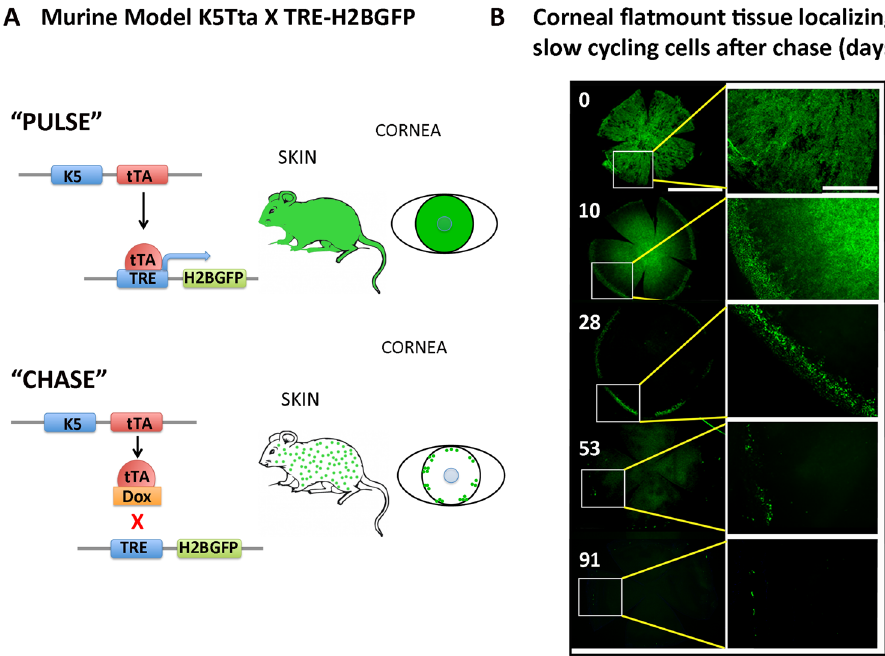
Figure 1. Murine K5Tta × TRE-H2BGFP identifies limbal localized GFP + cells in corneal wholemount tissue. ( A ) Tetracycline-inducible (tet-off) double transgenic mouse system drives expression of histone H2B–GFP from the epithelial keratin 5 (K5) promoter (pulse). Dox administration in mouse diet turns off H2B–GFP expression (chase) when proliferating epithelial cells dilute the label between daughter cells by divisions. ( B ) Corneal flatmount tissue localizing slow cycling cell populations from K5tTA X TRE-H2BGFP mice starting from 0–91 d chase. Low magnification of the entire cornea is displayed on the left panel after 0 (n = 4), 10 (n = 2), 28 (n = 3), 53 (n = 5) and 91 (n = 3) d chase and higher magnifications from the boxed areas on the left panel are shown on the right. GFP + nuclear staining marks the majority of the corneal epithelium at 0 d chase. At 10 d chase GFP positive nuclei are scattered throughout the cornea, with a distinct lack of GFP + cells separating the periphery and the central cornea. Low magnification of 28 d chase shows few GFP + cells in a cluster localized to the periphery. The enlarged image at 28 d shows these GFP + nuclei at the peripheral base and the limbal region. Low magnification of 53 d chase exhibits fewer cells in the periphery compared to 28 d chase, and the enlargement shows the limbal localization of these cells. At 91 d chase, GFP + cells become few, but the location of GFP + cells remain at the limbus as highlighted in the enlarged image on the right panel. Scale bar in B for right panel = 1000 µ m and for the left panel images = 400 µ